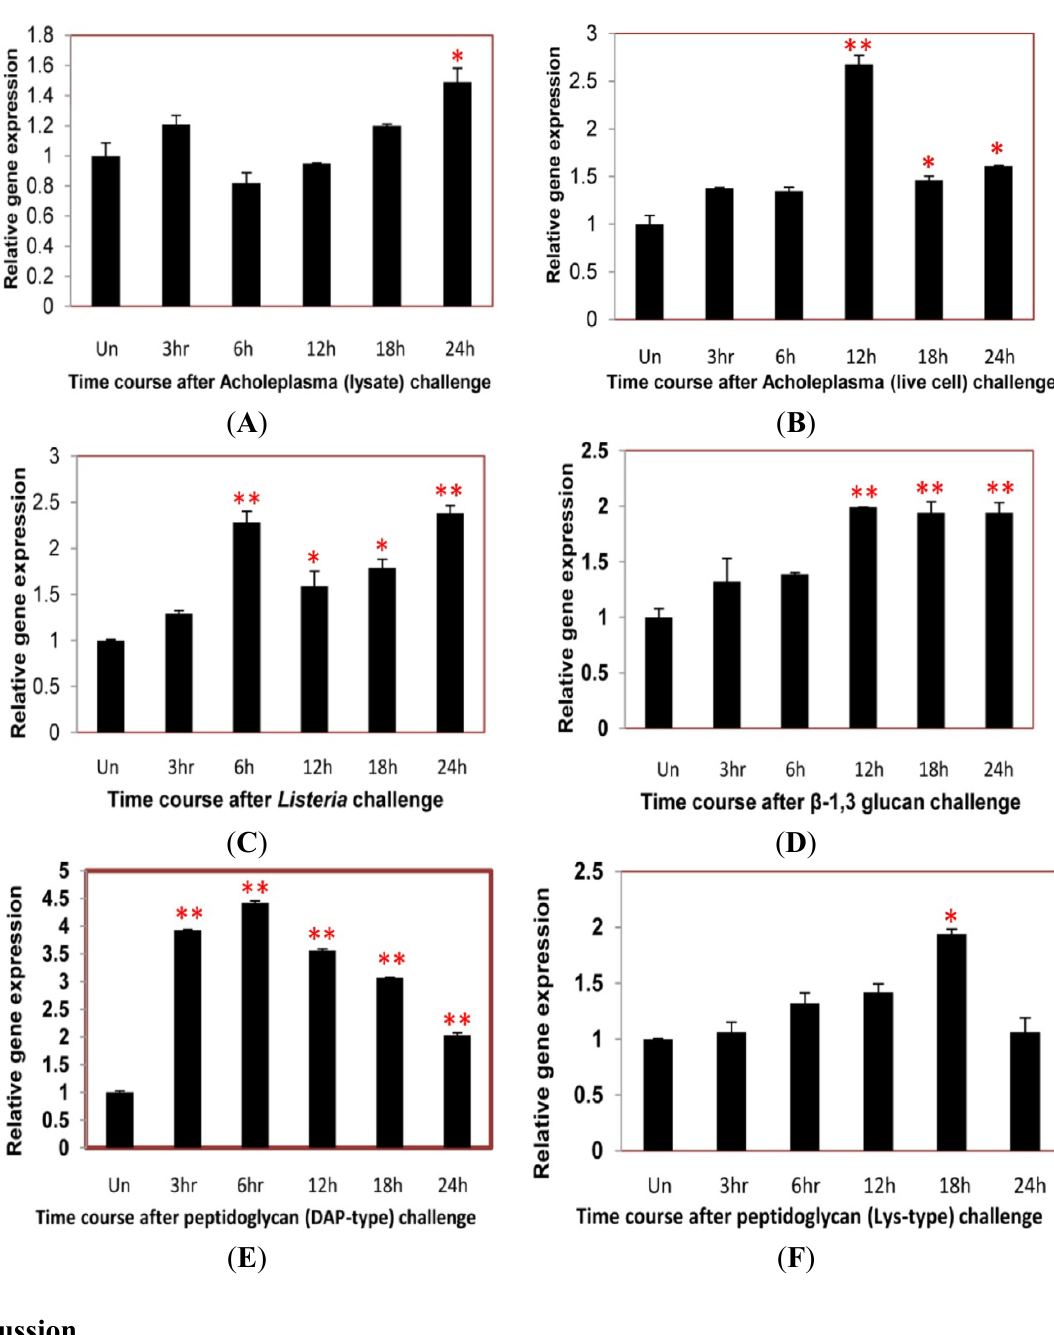
Figure 9. Time-course expression of CD63 homologue in T. molitor after injection with ( A ) Acholeplasma laidlawii lysate; ( B ) Acholeplasma live cell; ( C ) Listeria monocytogenes ; ( D ) β -1, 3 glucan; ( E ) DAP-type Peptidoglycan and ( F ) Lysine-type (Lys-type) peptidoglycan. Total RNA was extracted from Tenebrio molitor larvae after interval of 3, 6, 12, 18 and 24 h post inoculation and profiled by real-time PCR. Ribosomal protein L27a ( Tenebrio molitor ) gene was used as internal control. Vertical bars represent standard deviations ( n = 3). * p < 0.05, ** p <